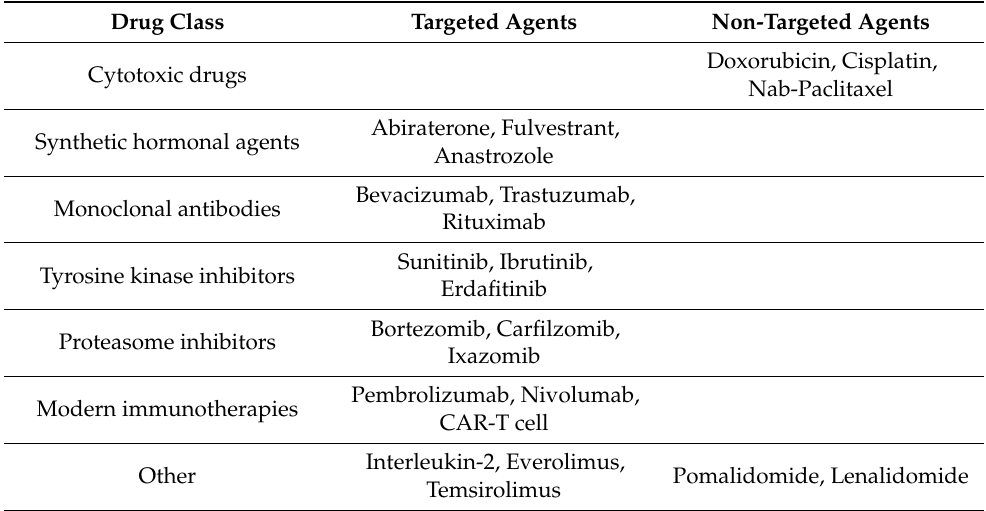
Table 1. Targeted and non-targeted agent